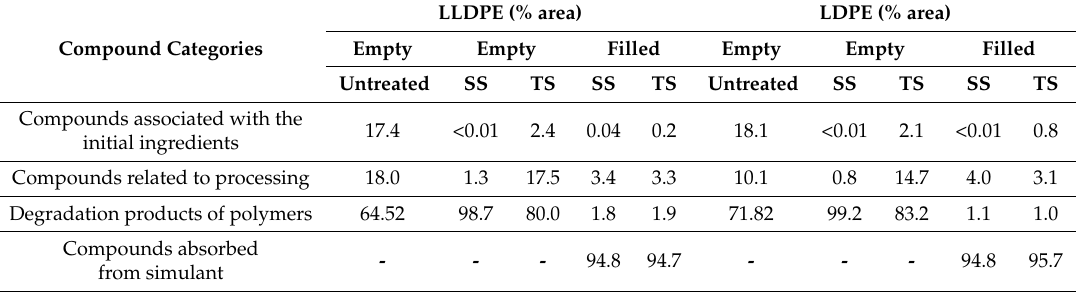
Table 7. Percent area of substances extracted with the Head Space Solid Phase microextraction (HS-SPME) method and analyzed by GC/MS from linear low-density polyethylene (LLDPE) and low-density polyethylene (LDPE) single dose containers, both empty and filled with simulant, after simulated solar irradiation (SS) and thermal shock (TS), compared with untreated samples.